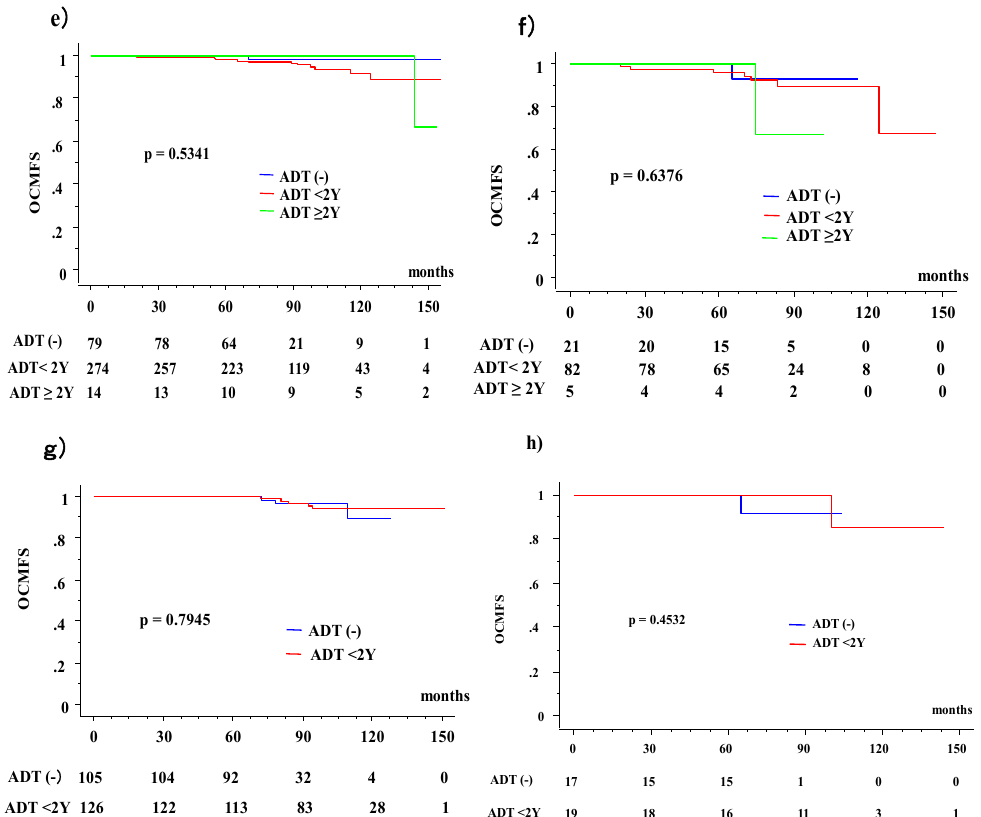
Figure 2. Other-cause of mortality (OCM) with or without androgen deprivation therapy (ADT) according to age. ( a ) OCMFS according to three ADT groups divided by duration (ADT naïve, ADT <2 years (2Y), and ADT ≥ 2 years (2Y)) in younger population. ( b ) OCMFS according to three ADT groups divided by duration in elderly population. ( c ) OCMFS according to three ADT groups divided by duration in high-risk group of younger population. ( d ) OCMFS according to three ADT groups divided by duration in the high-risk group of the elderly population. ( e ) OCMFS according to three ADT groups divided by the duration in the intermediate-risk group of the younger population. ( f ) OCMFS according to three ADT groups divided by the duration in the intermediate-risk group of the elderly population. ( g ) OCMFS according to three ADT groups divided by the duration in the low-risk group of the younger population. ( h ) OCMFS according to three ADT groups divided by the duration in the low-risk group of the elderly population. OCMFS = other-cause of mortality (OCM)-free survival rate.